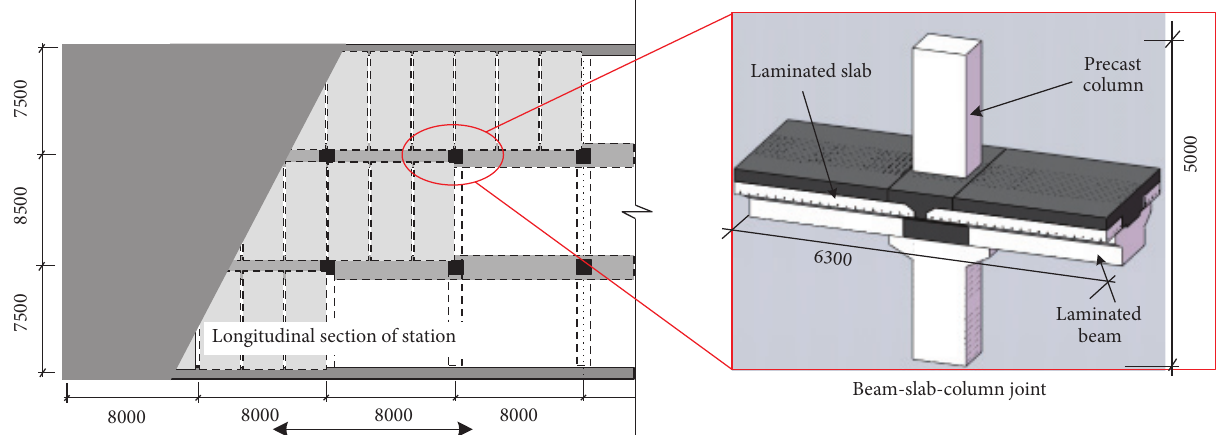
Figure 1: Structure diagram of the subway station and isolated reinforced concrete beam-slab-column